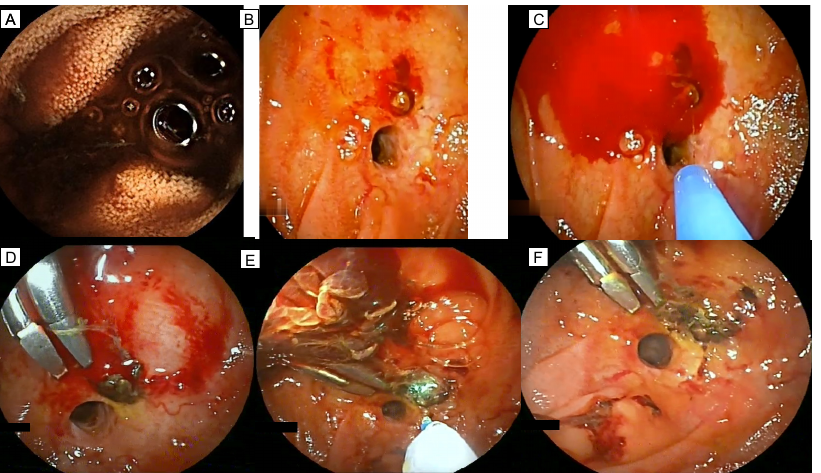
Figure 1. The main findings of the performed enteroscopies are shown. At capsule endoscopy, blood was present at jejunojejunostomy coming from the hepatic limb ( A ). During anterograde double- balloon enteroscopy, active bleeding from the afferent limb was observed with the presence of fresh blood at the jejunojejunostomy. Retrograde underwater exploration of the afferent limb showed the presence of an adherent clot close to the hepaticojejunostomy ( B ). Upon clot removal, an oozing hemorrhage from a visible vessel was observed and treated with argon plasma coagulation (30 W) ( C ). Subsequently, two endoclips were placed with a partial control of the bleeding ( D ). Finally, dual emission laser 1.9/1.5 μ m was applied (Opera and Opera Evo by Quanta System, Samarate, Italy) ( E ) with the complete bleeding arrest ( F ).